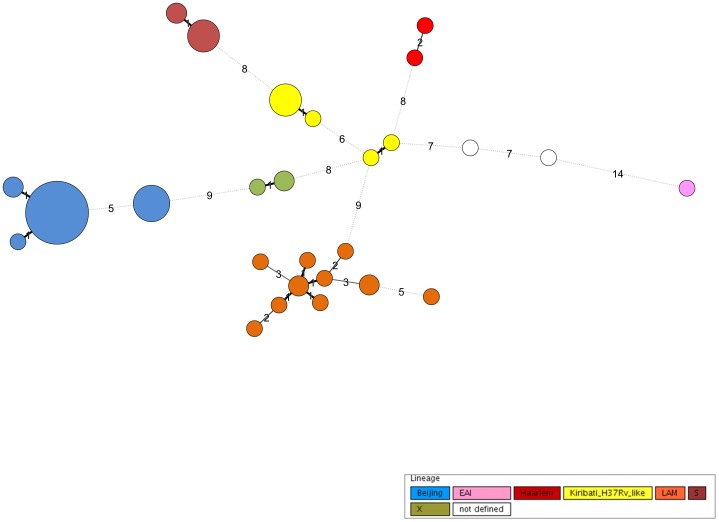
Minimum Spanning Tree of 24 loci MIRU-VNTR data.Minimum Spanning Tree, based on the 24 loci MIRU-VNTR typing data of 73 analysed Kiribati strains. The size of each circle is proportional with the number of MIRU-VNTR types belonging to a particular complex. Classification of the strains into the different phylogenetic lineages is visualized by color coding.